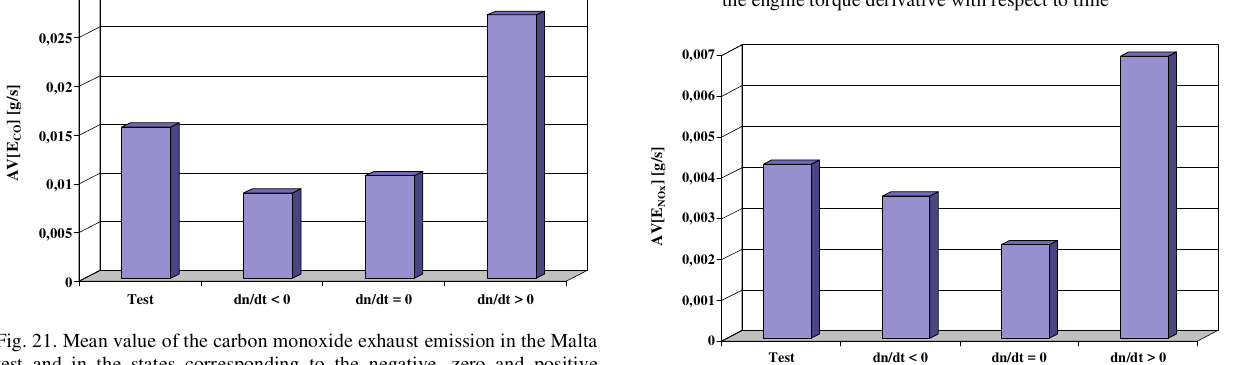
Fig. 24. Mean value of the hydrocarbons exhaust emission in the Malta test and in the states corresponding to the negative, zero and positive values of the engine torque derivative with respect to time